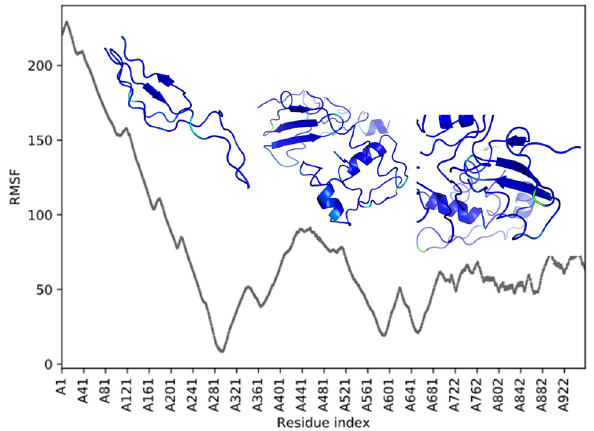
Figure7: Rootmeansquarefluctuation(RMSF)plotofthe refined POTEE structure post-REMD